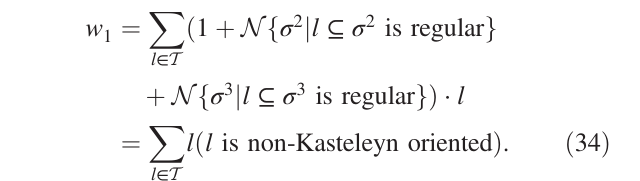
dots).FIG. 13. Triangulation T (solid black line), resolved triangula- ˜ T ˜ P tion (solid and dashed black lines), and resolved dual lattice ˜ T (red line). The resolved triangulation is obtained from the original T by addinga new vertex to the center of each tetrahedron. The links of P have orientations induced from the link orientations of T according to the conventions shown in Fig. 14(a). Red dots on ˜ P thevertices of represent Majorana fermions, which are split from complex fermions on each face of T .